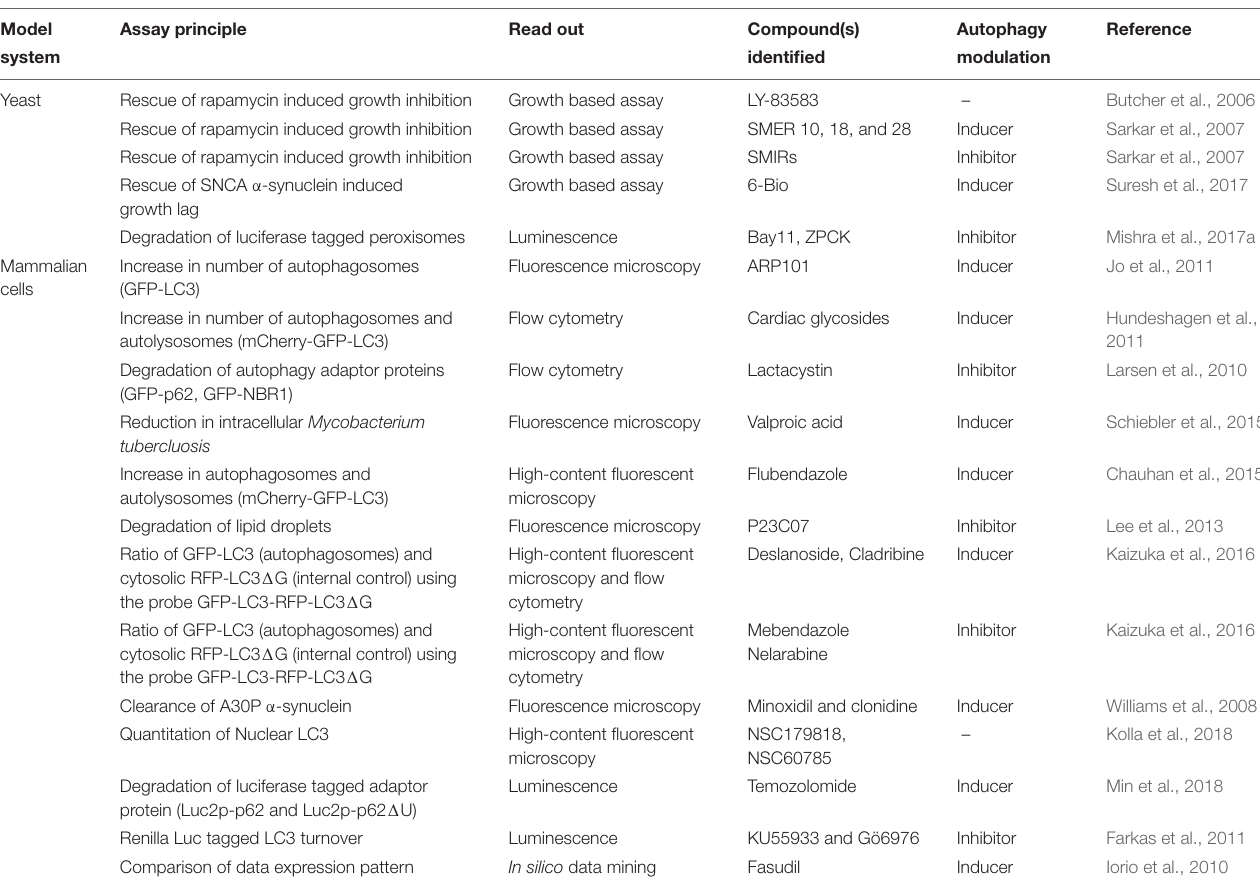
TABLE 2 | Summary of HTS assays for compound